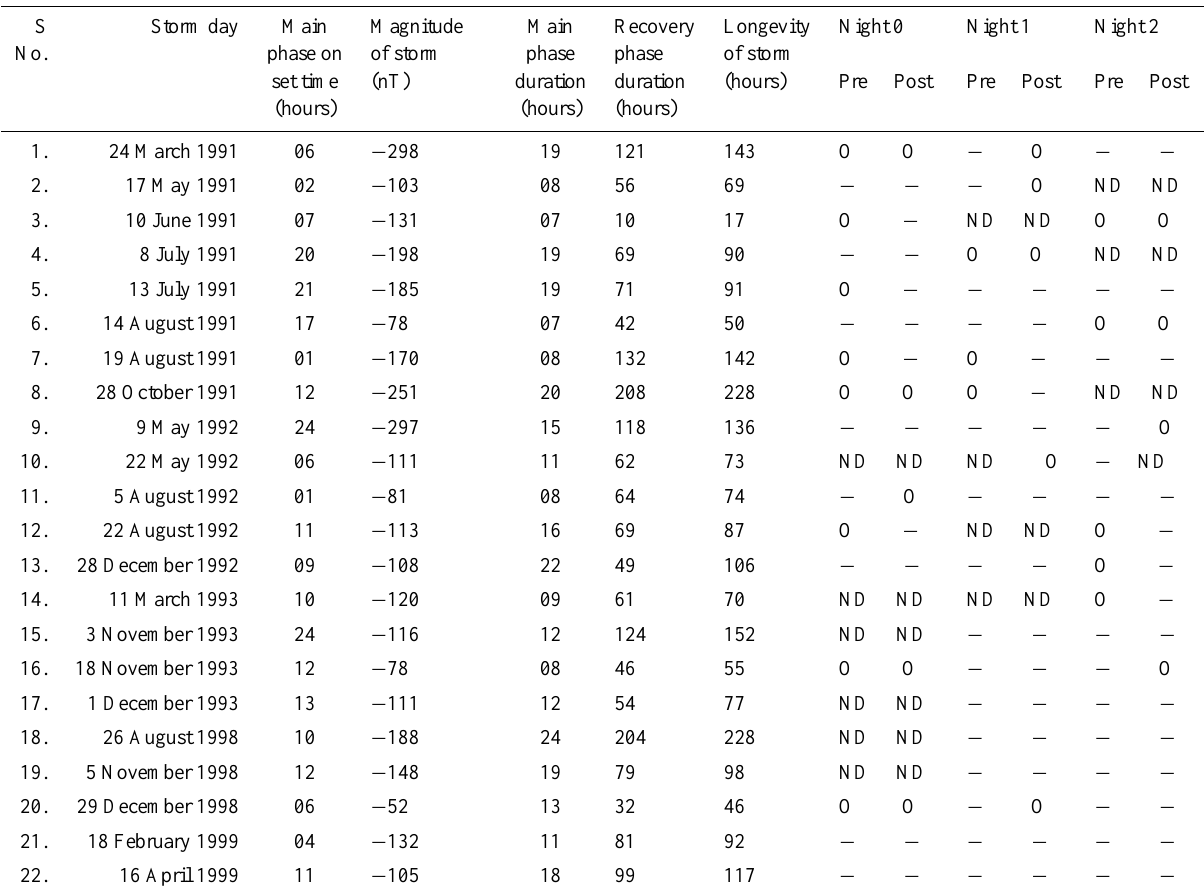
Table 1. Nighttime scintillation activity for the geomagnetic storm ( D st < − 50nT), IST=UT+5.5h; O=Scintillation present; − =No Scintil- lation; ND= No